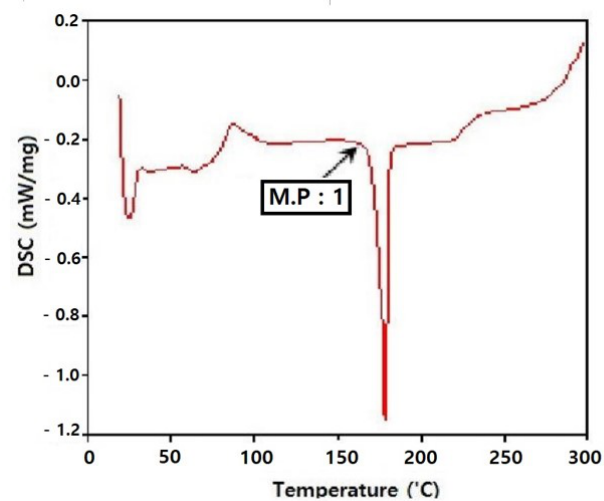
Figure 6. Melting analysis of films using a differential scanning calorimeter. The melting point (M.P:1) of the film is 175 °C.